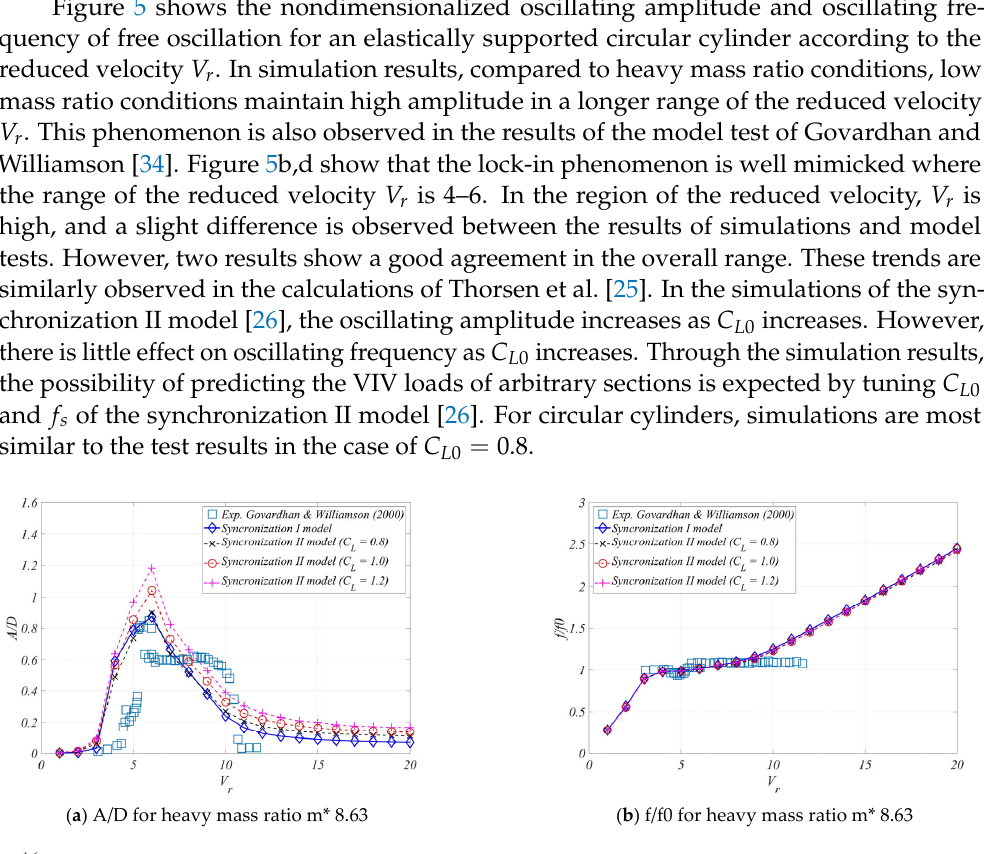
Figure 4. Free oscillations for elastically supported circular cylinder. Table 1. Simulation parameters, free oscillations [34].